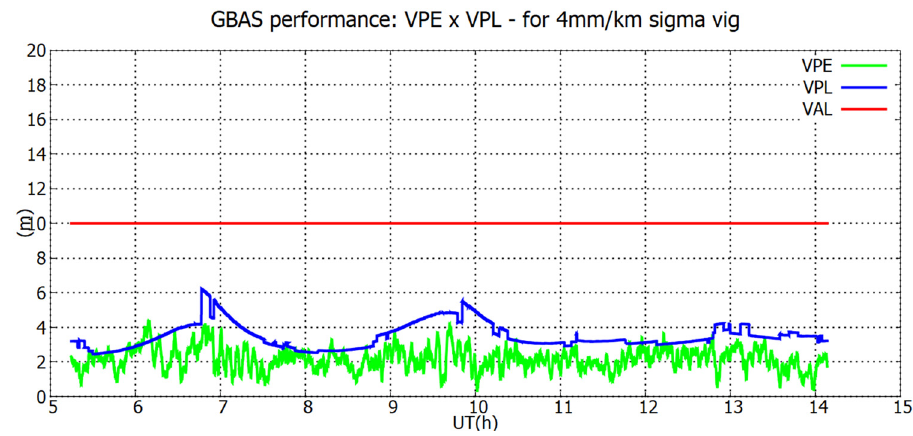
Figure 10: Performance of positioning errors and protection levels for GBAS simulation considering σ vig of 4 mm/km.